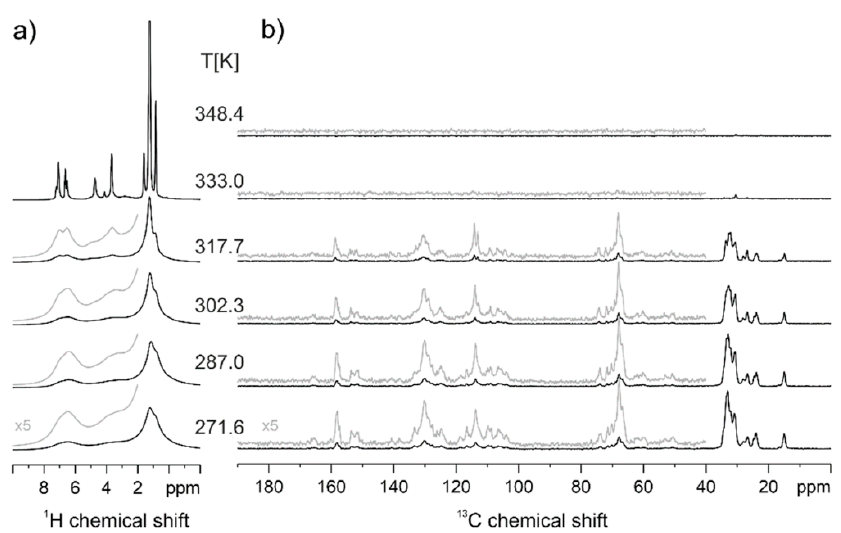
Figure 7. PAZE40 1 H MAS ( a ) and 13 C CP-MAS ( b ) NMR spectra at variable temperature. In brackets, the temperature values corrected for frictional heating under fast MAS conditions are reported.